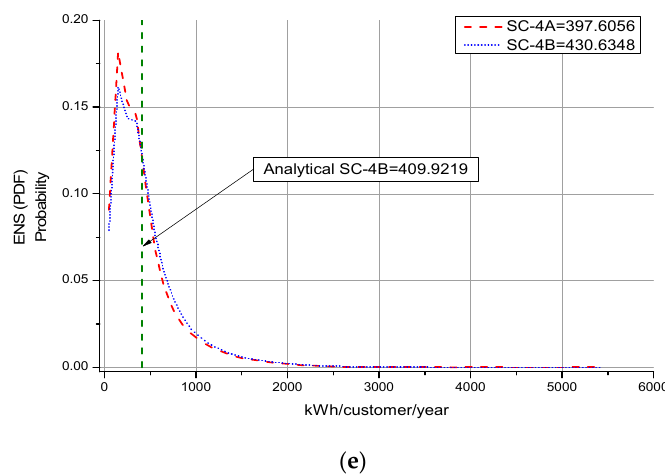
Figure 4. Indices for scenario SC-4A/4B; ( a ) SAIFI index; ( b ) MAIFI index; ( c ) SAIDI index; ( d ) CAIDI index; and ( e ) ENS index.